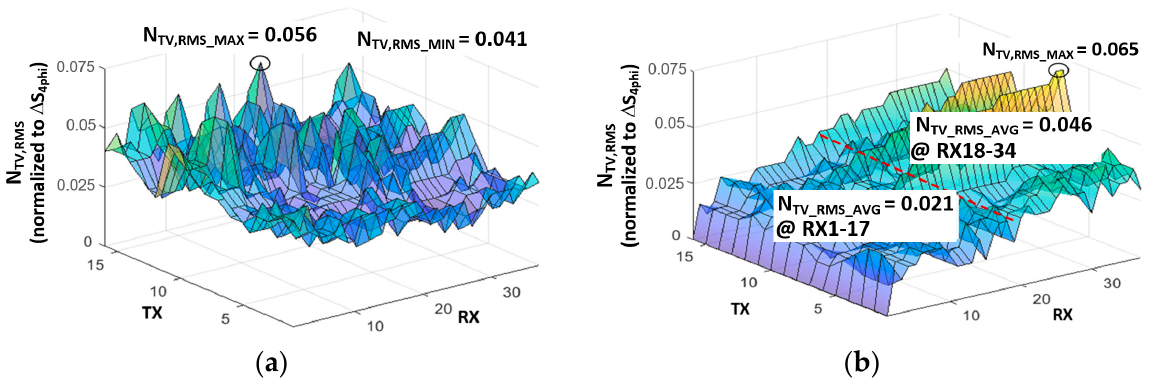
Figure 4. Reconstruction of single-ended capacitances.